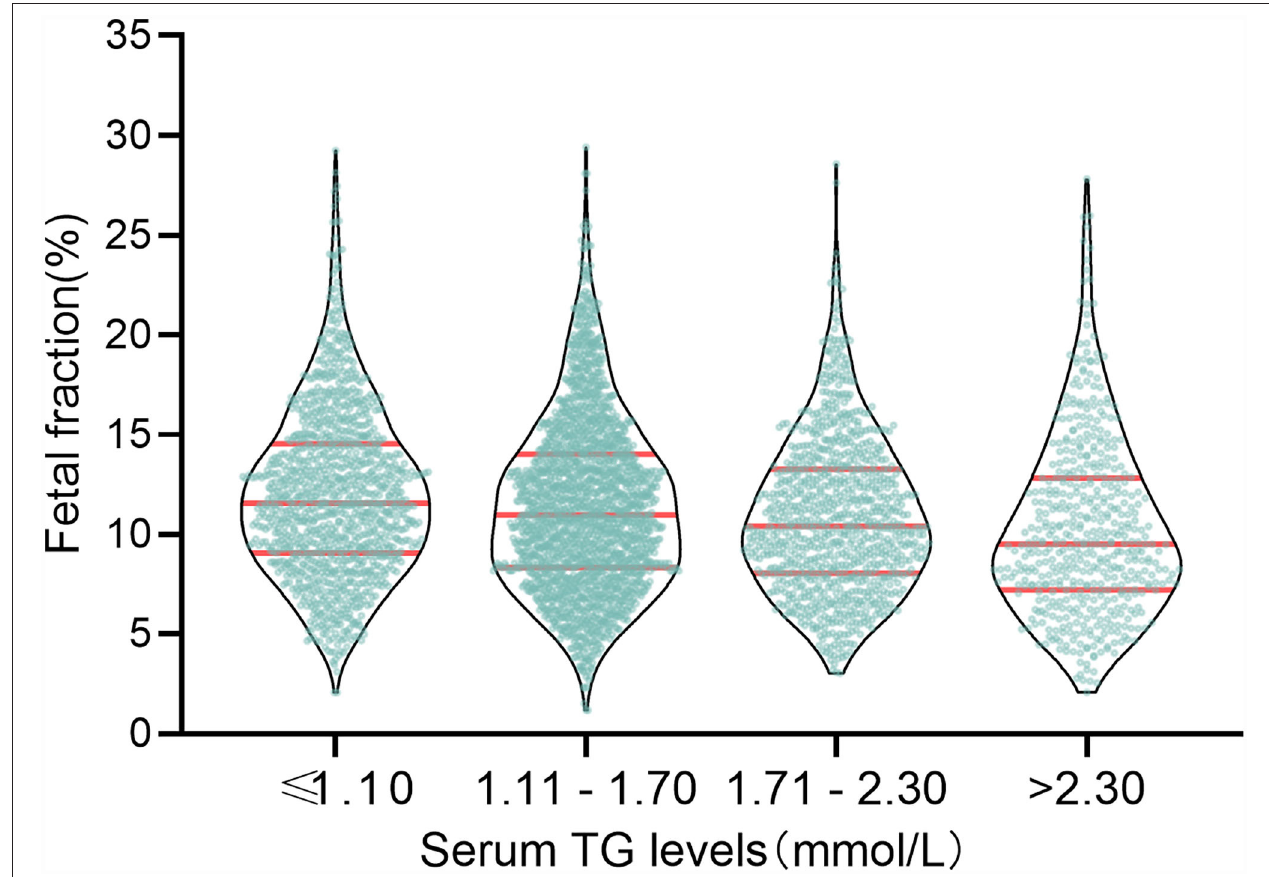
FIGURE 3 | Mean fetal fraction across TG